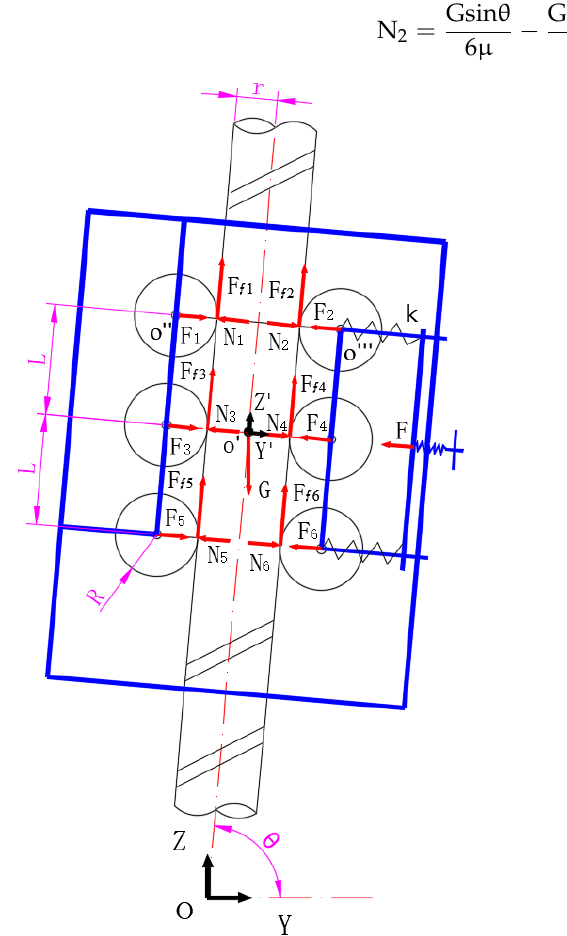
Figure 5. Force diagram of the robot in the YOZ coordinate plate.